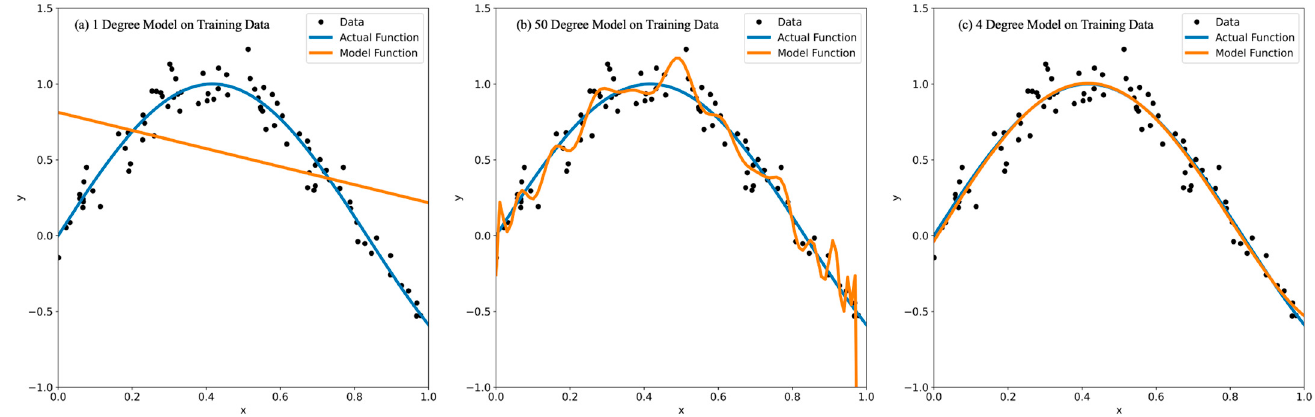
Figure 1. Underfitting and overfitting examples on randomized data with 1, 50, and 4 degree model.